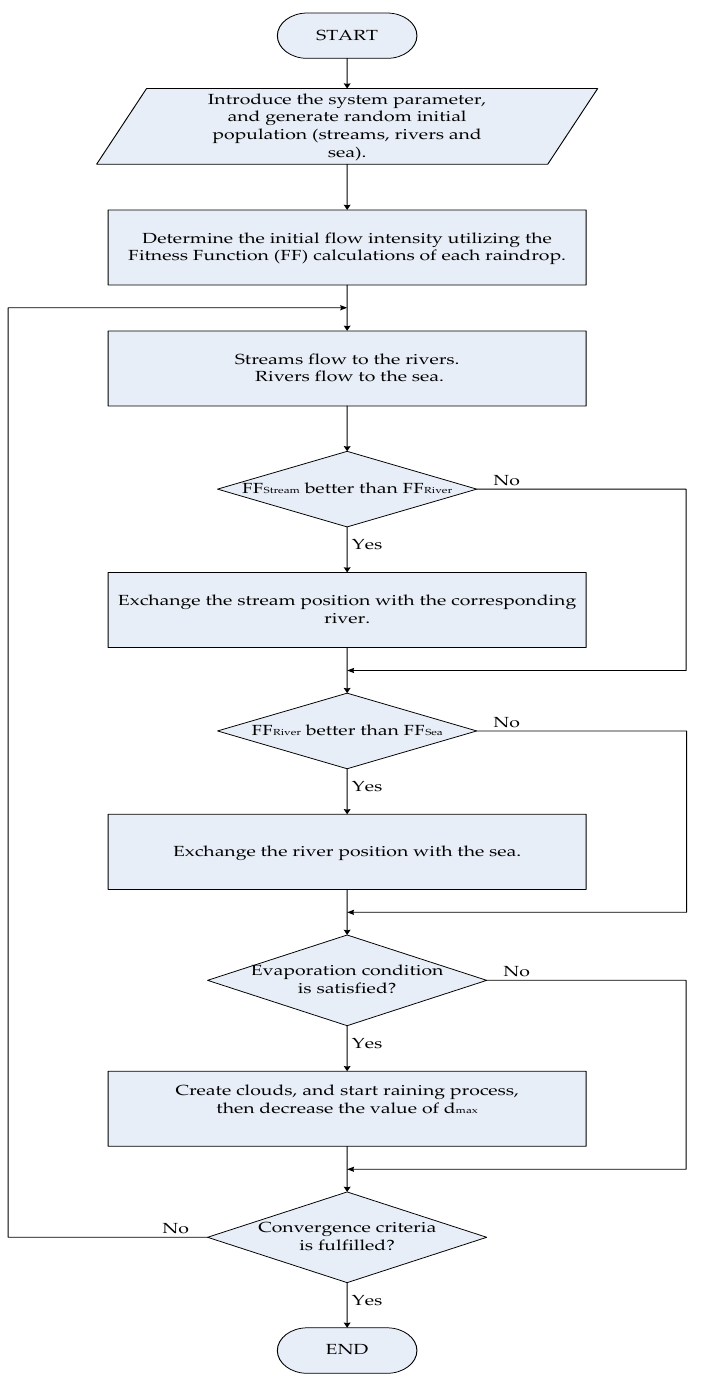
Figure 6. Flowchart for the Water Cycle Optimization Technique